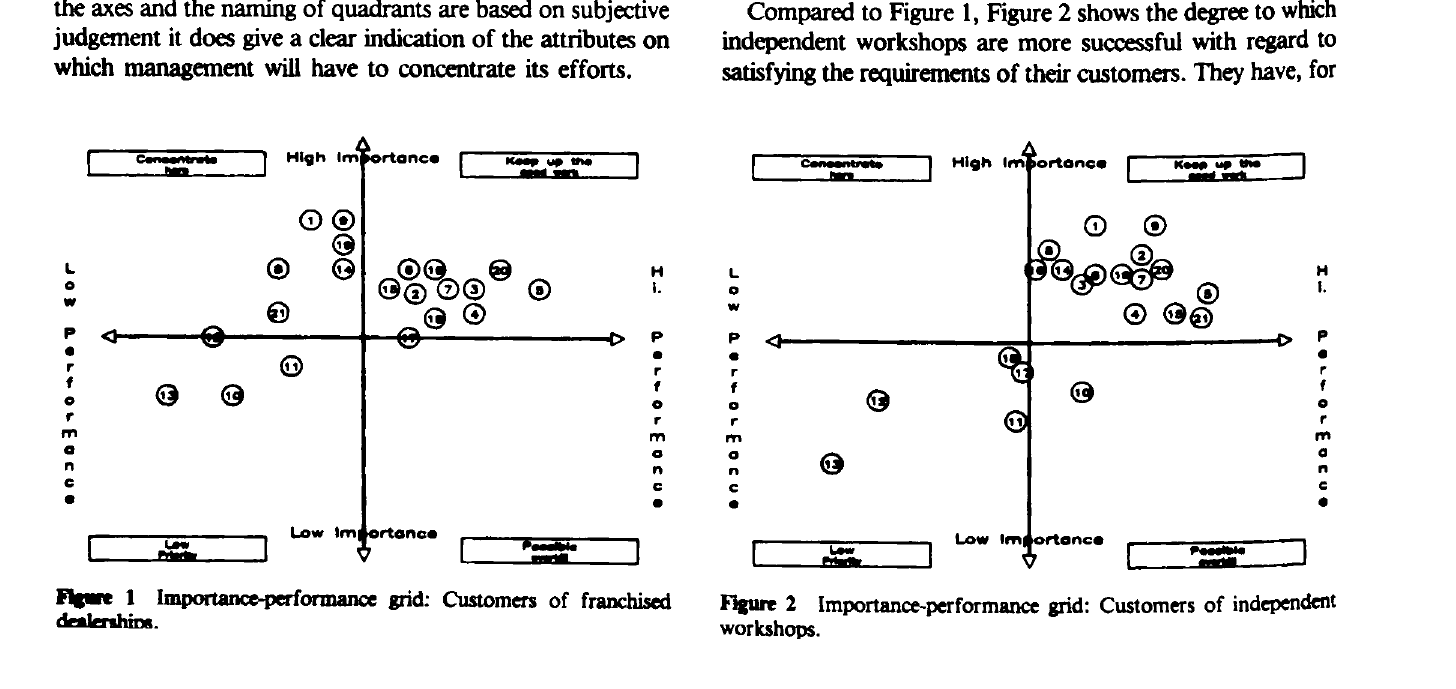
t1pre 1 lmportance..perormana: grid: Customers of franchised